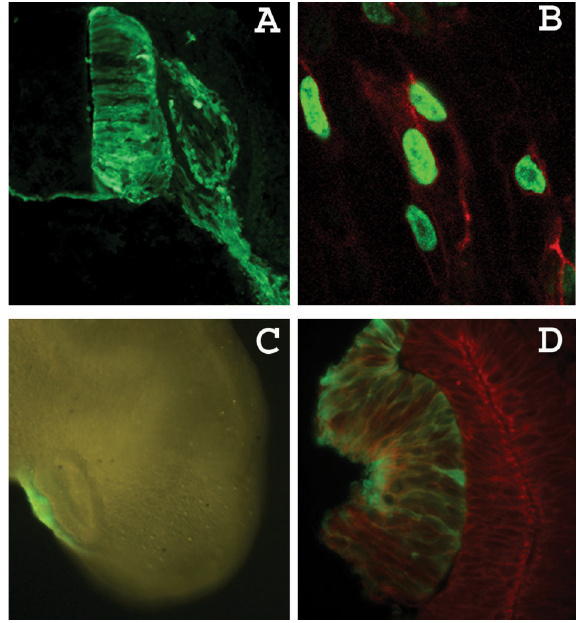
Figure 3. Electroporation results. A , Cross-section view of an electroporated neural tube after cryosections and immunofluor- escence detection of enhanced green fluorescent protein (eGFP). The electroporated GFP-positive cells are restricted to the right half of the neural tube and the right dorsal root ganglion (DRG). GFP can also be detected in the commissural neurites that cross to the contralateral neural tube and in the motor neuron projections. Dorsal is up. B , Neural crest cells electroporated with a plasmid encoding the fusion protein Tomato-2A-H2GFP, which is cleaved intracellularly to label the cell membrane with red fluorescence and the cell nucleus with green fluorescence. C , Fluorescence microscope view of a live embryo (embryonic day 3) with the electroporated right lens placode expressing GFP. D , Visualization of GFP (green) and actin (red) in the lens placode after processing cryosections for immunofluorescence with anti- GFP antibody (Abcam, UK) followed by exposure to rhodamine- labeled